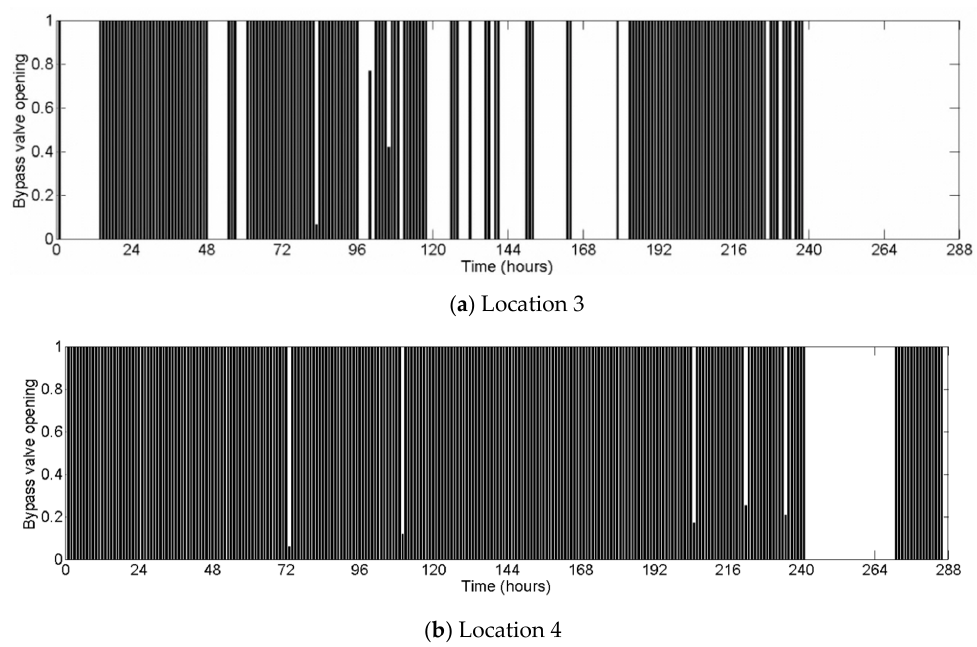
Figure 11. Operational scheduling for the bypass valves of the two NC 100–200 turbines installed at locations 3 and 4.